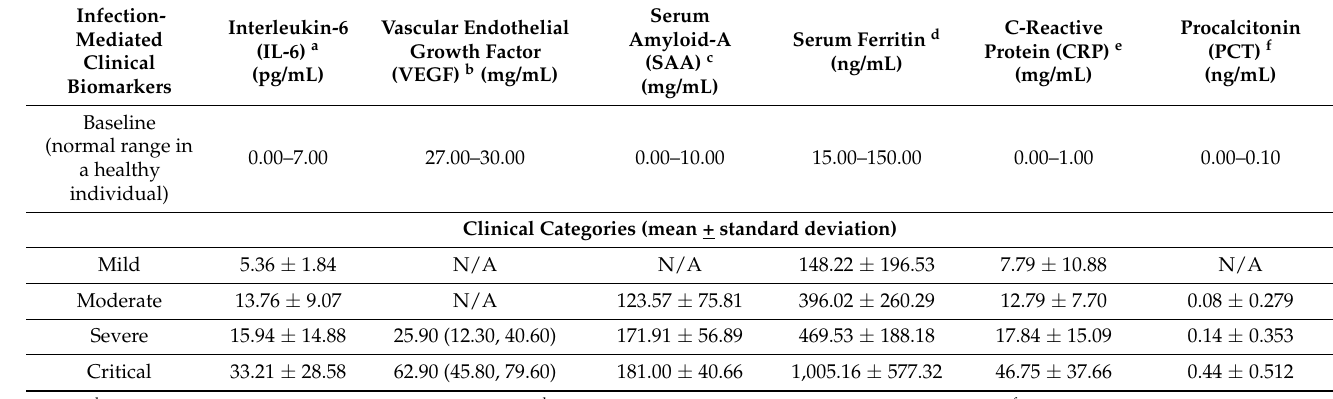
Table 1. Concentrations of infection-mediated clinical biomarkers in normal and four clinical types (mild, moderate, severe, and critical) of COVID-19